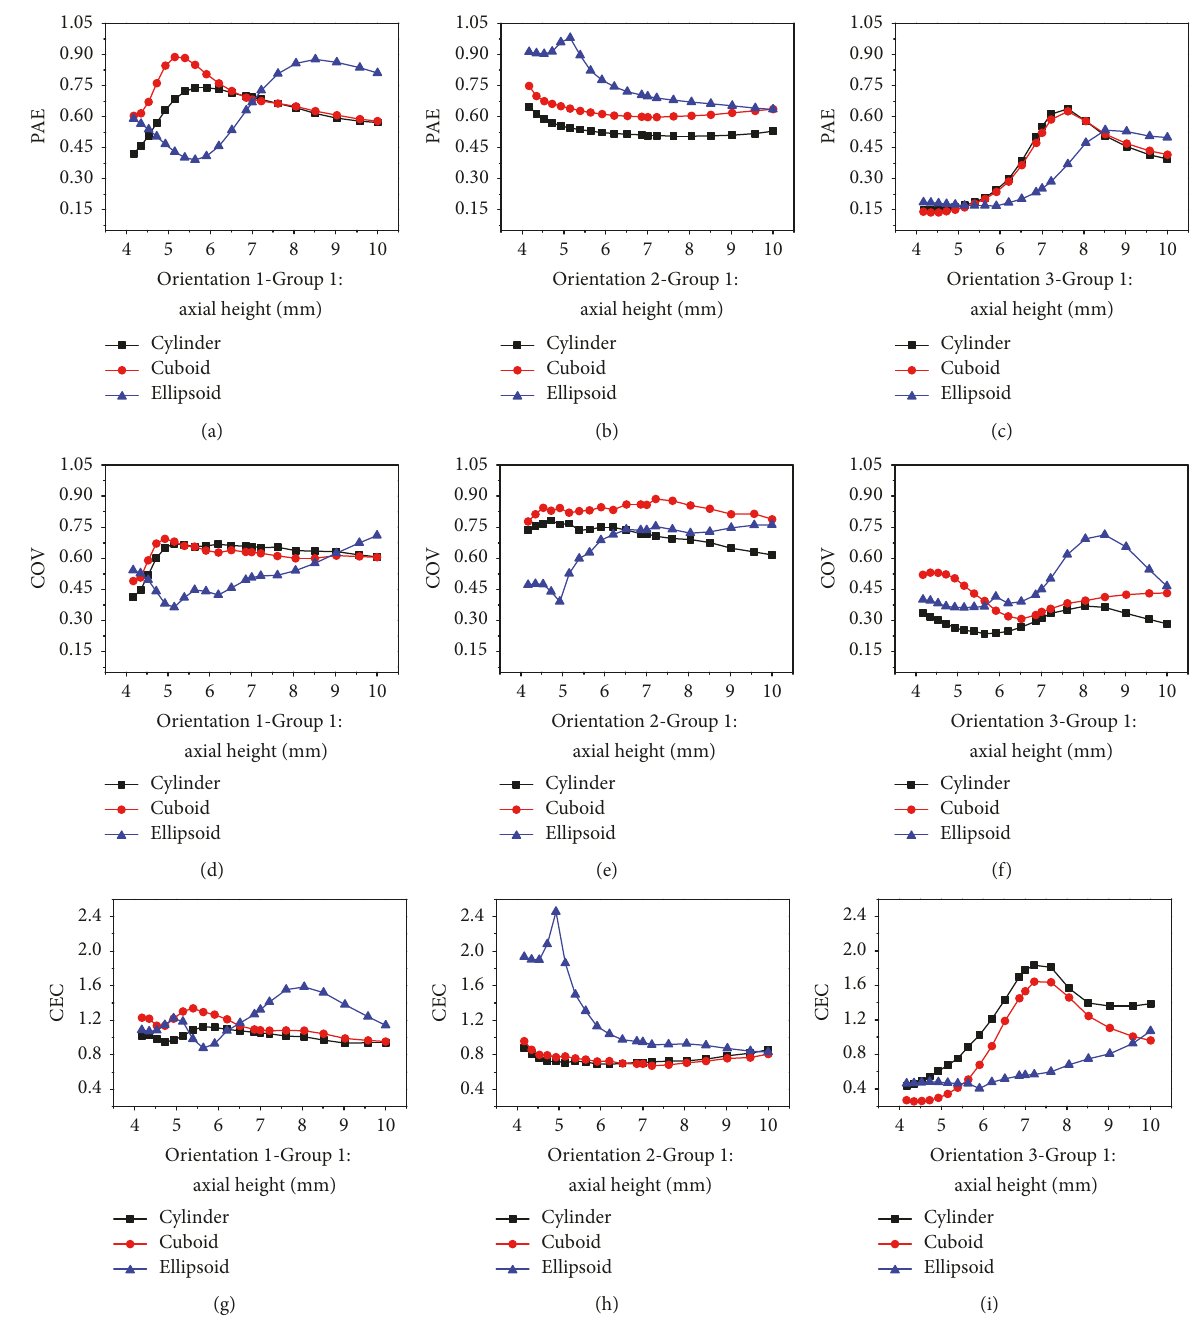
Figure 20: Different samples in the same orientations, Group